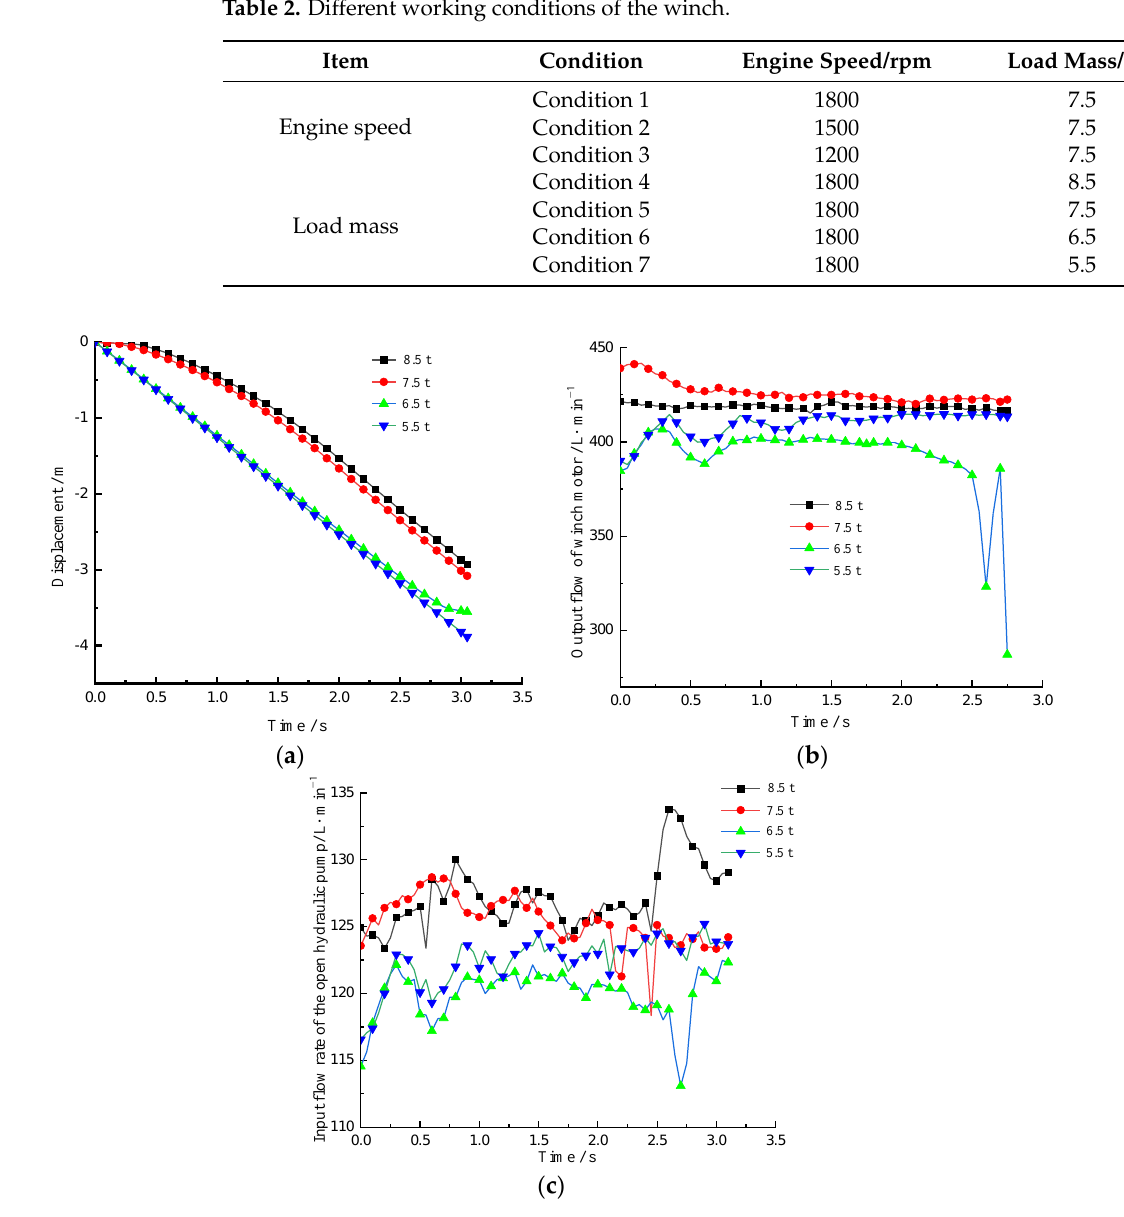
Figure 9. Characteristic curves under different load masses. ( a ) Displacement curves when winch descending; ( b ) Flow rate curves of winch motor; ( c ) Input flow rate of the open hydraulic pump. The four-quadrant pump/motor power, the winch motor output power, and the open hydraulic pump input power can be deduced